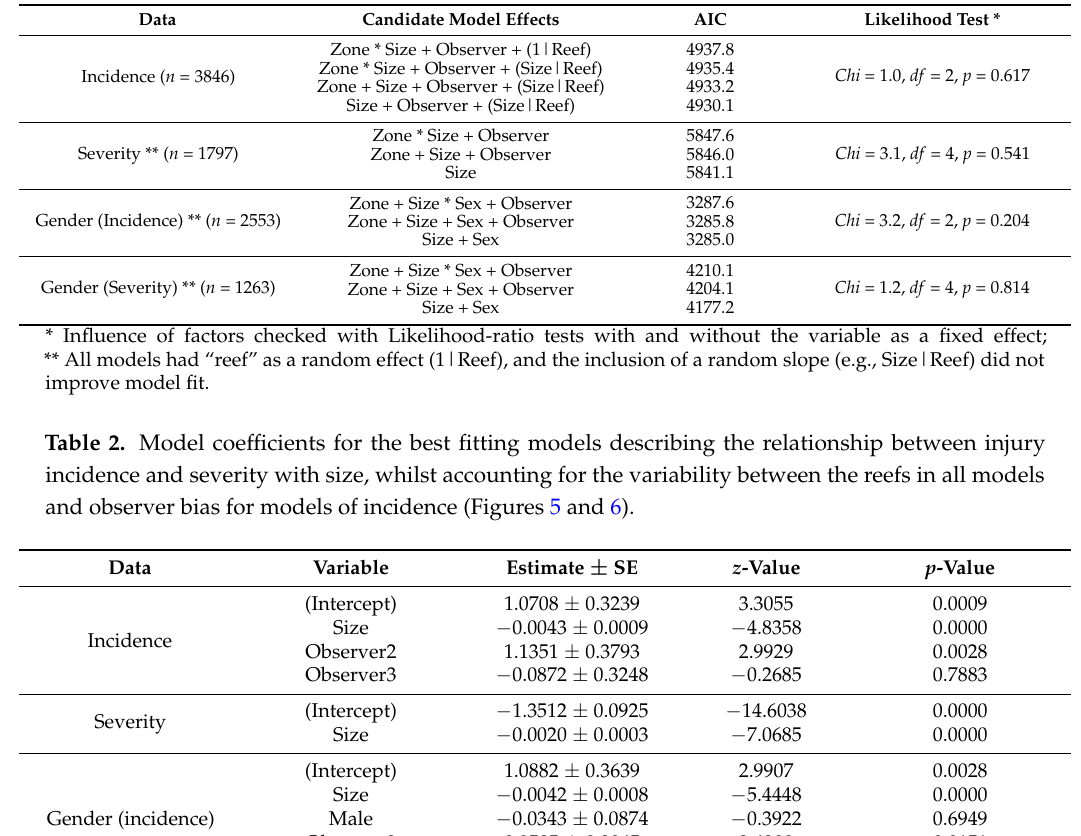
Table 1. Overview of the model selection process, starting with the full model including all relevant interactions, compared with Akaike Information Criterion (AIC) and Likelihood-ratio tests.